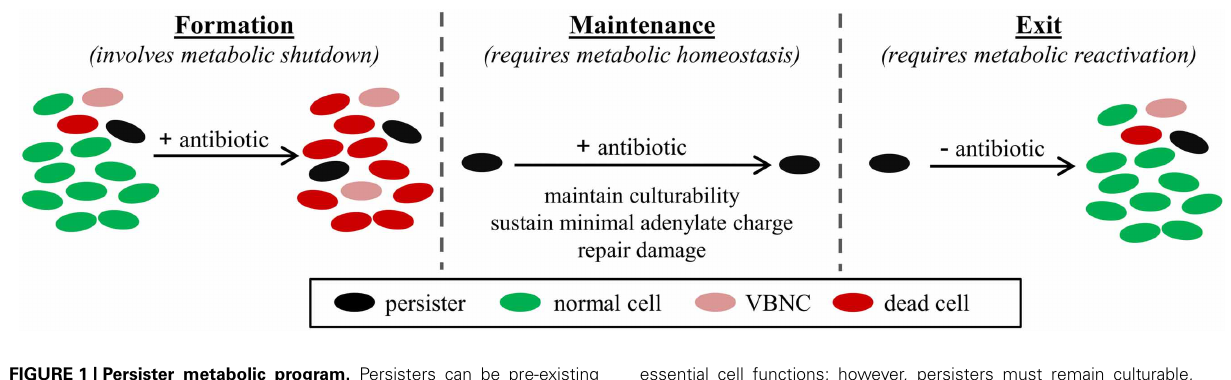
essential cell functions; however, persisters must remain culturable, which requires a minimal adenylate charge to be sustained (Chapman et al., 1971) and damage to be repaired (Nystrom and Gustavsson, 1998). Upon removal of the antibiotic, persisters exit their tolerant state and give rise to a bacterial population of identical antibiotic susceptibility as the original population (Balaban et al.,